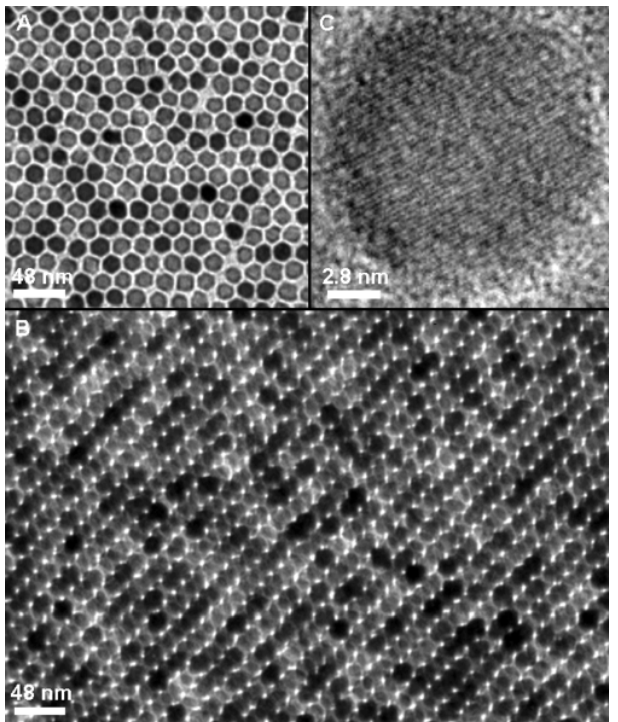
Figure 2. TEM images of 16-nm IONPs synthesized by the decomposition of organic precursors: ( A ) a monolayer assembly; ( B ) a multilayer assembly; ( C ) High Resolution Transmission Electron Microscopy (HRTEM) image of a single Fe Reproduced with permission from [13]. Copyright 2002, American Chemical